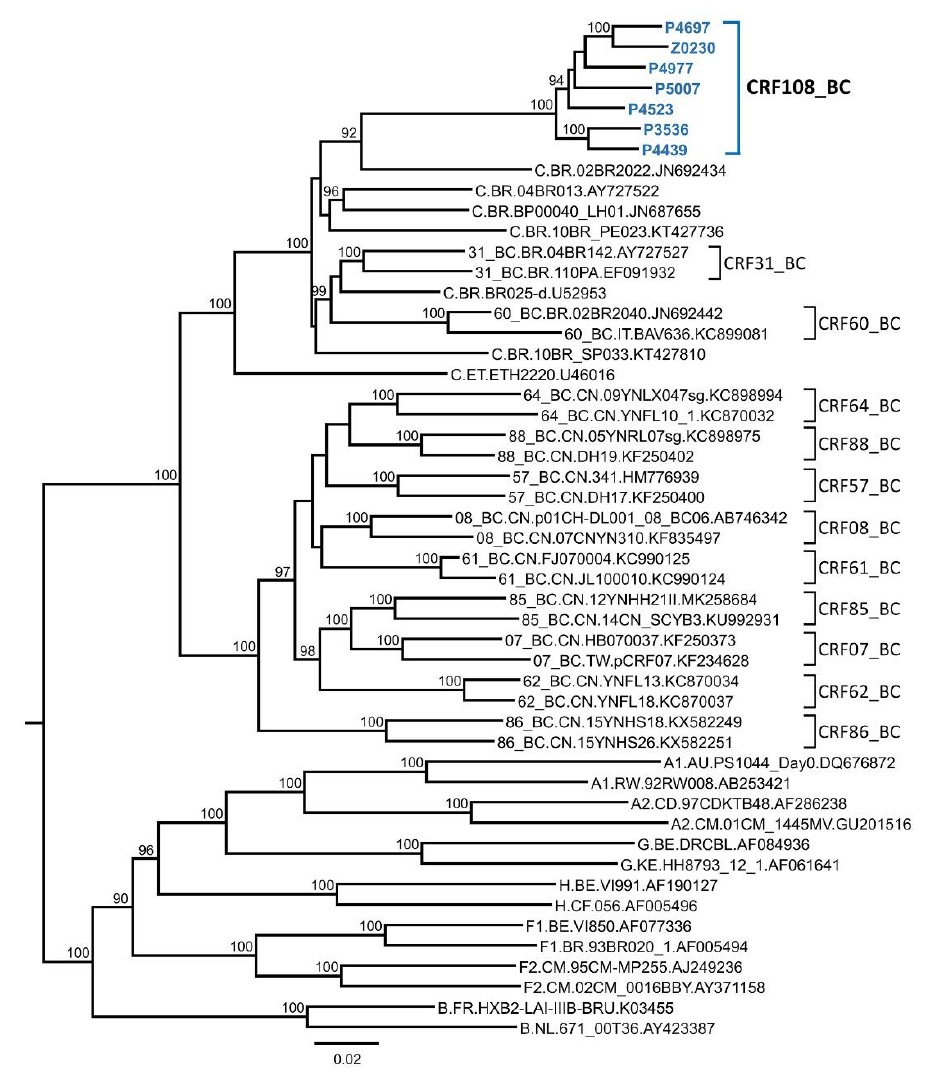
Figure 3. Maximum likelihood tree of NFLGs of CRF108_BC and all CRF_BCs identified to date. Only bootstrap values ≥ 90% are shown. CRF108_BC sequences are in blue and bold type. Database Scheme 108. BC, BLAST searches for similar sequences were done with subtype C and B fragments at the Los Alamos HIV Sequence Database. With regard to